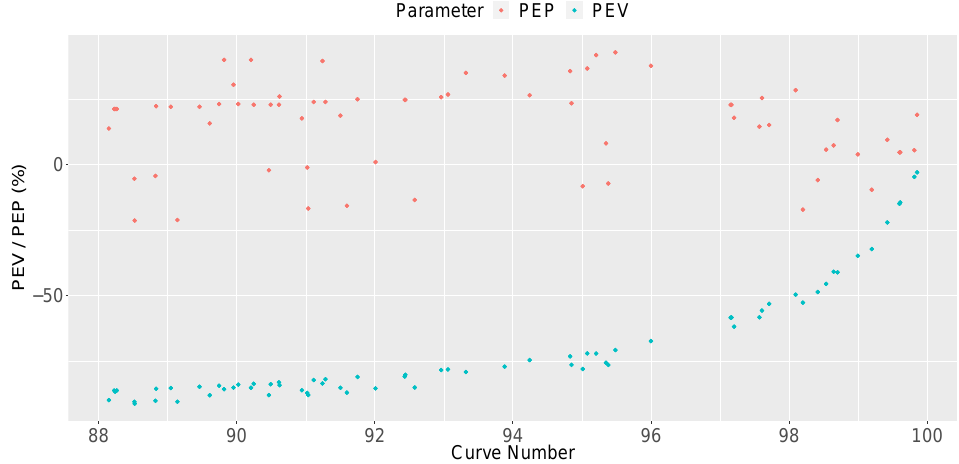
Figure 10. Computed PEP (red) and PEV (blue) values for a continuous